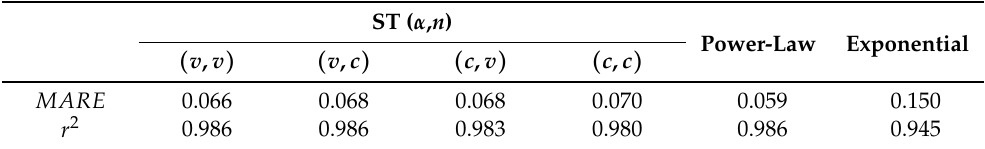
Figure 8. The correlation between the measured ( σ m ) and predicted ( σ p ) stresses using the two sets of constants, where α , n are considered both as functions of strain (green circles) and constants (red diamonds). The continuous black line represents a perfect correlation. Table 2. The goodness of fit assessed by MARE (Equation (4a)) and r 2 (Equation (4b)) between σ m and σ p for the four sets of the ST model and its limiting power-law and exponential models. See Appendix A for the details of the limiting